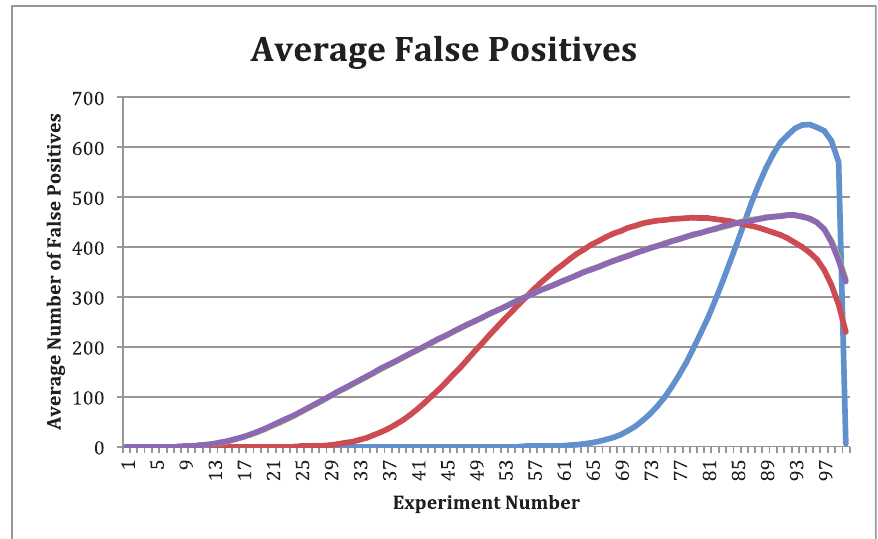
Figure 5. The number of false positives as a function of the number of experiments. These numbers are averaged over all 1000 simulations for each method. Blue corresponds to MINE-like, red to MINE, green to MINE with random orthonormal basis, and purple to MINE with random rotation. The final two overlap almost exactly which is why the green line is not visible.